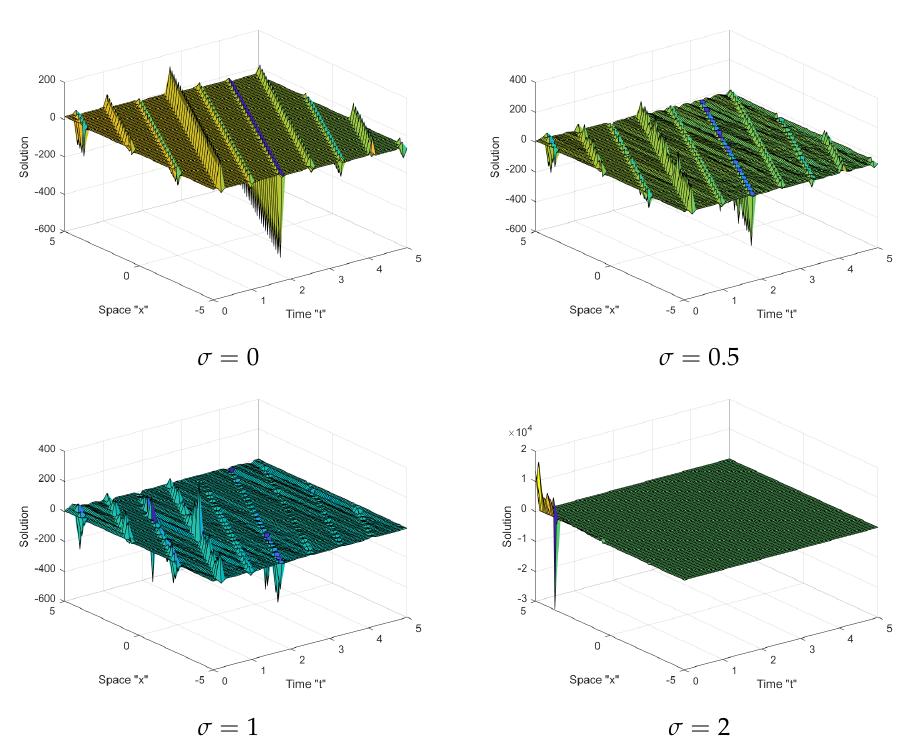
Figure 2. 3D plot of the obtained solution ϕ 2,1 ( x ,1, t ) of Equation (33).